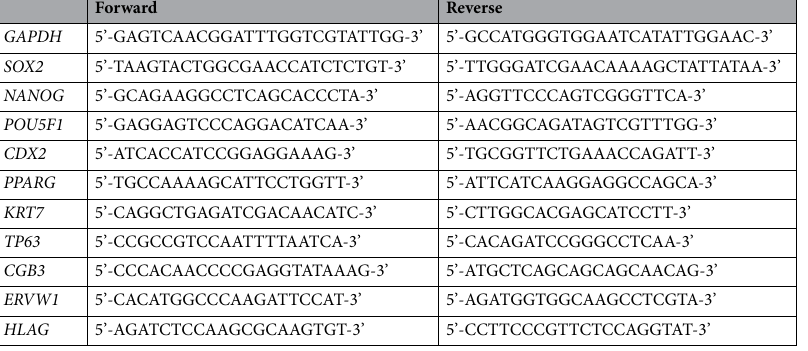
Table 1. Primer sequences used for